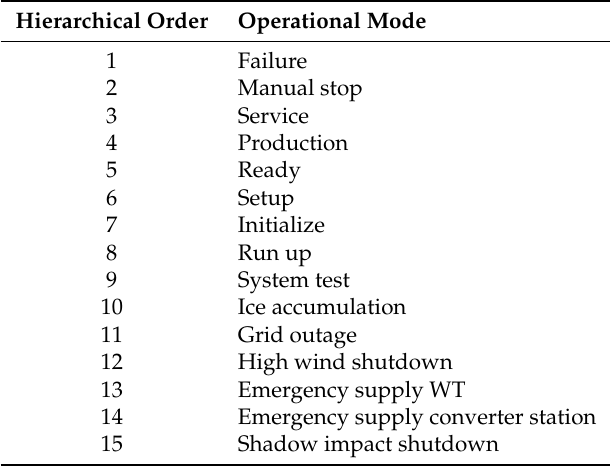
Table 1. Hierarchy of operational modes in descending